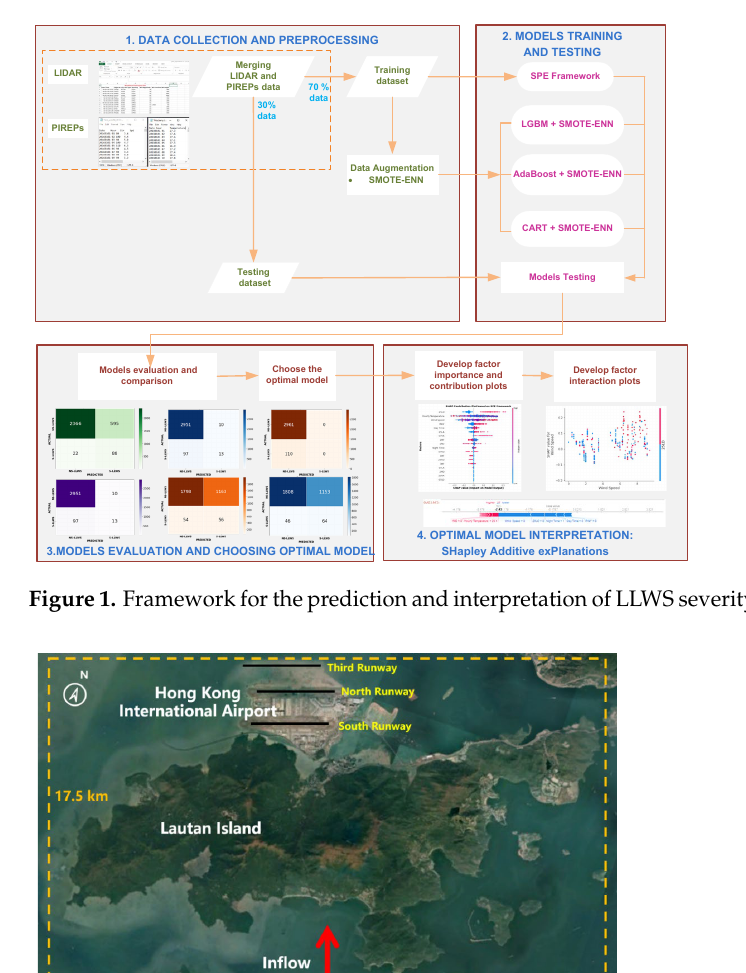
Figure 1. Framework for the prediction and interpretation of LLWS severity in the vicinity of run- ways.